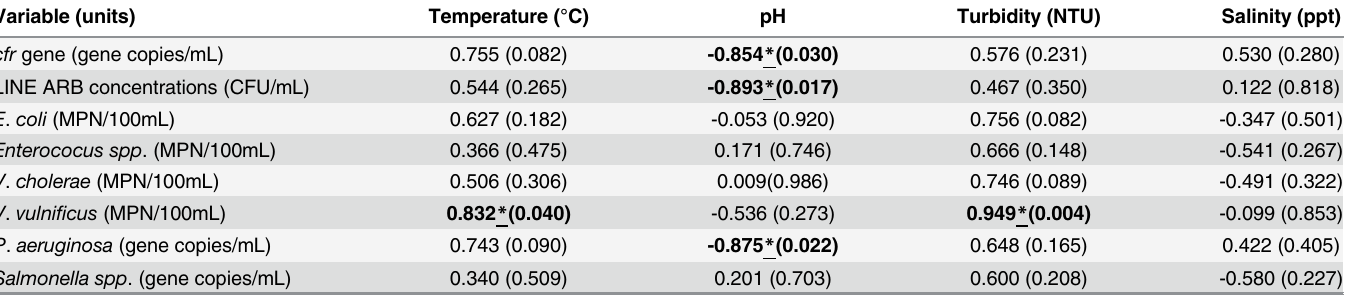
Table 6. Pearson correlation analysis of environmental variables to ARG, ARB and indicator organism measurements from ballast and harbor waters. Variable